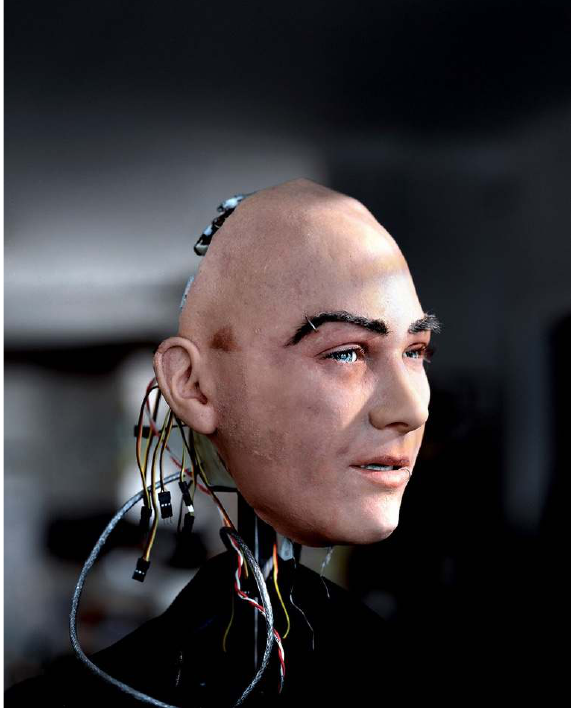
Figure 3: Max Aguilera-Hellweg, A partially assembled Joey Chaos, humanoid series ,